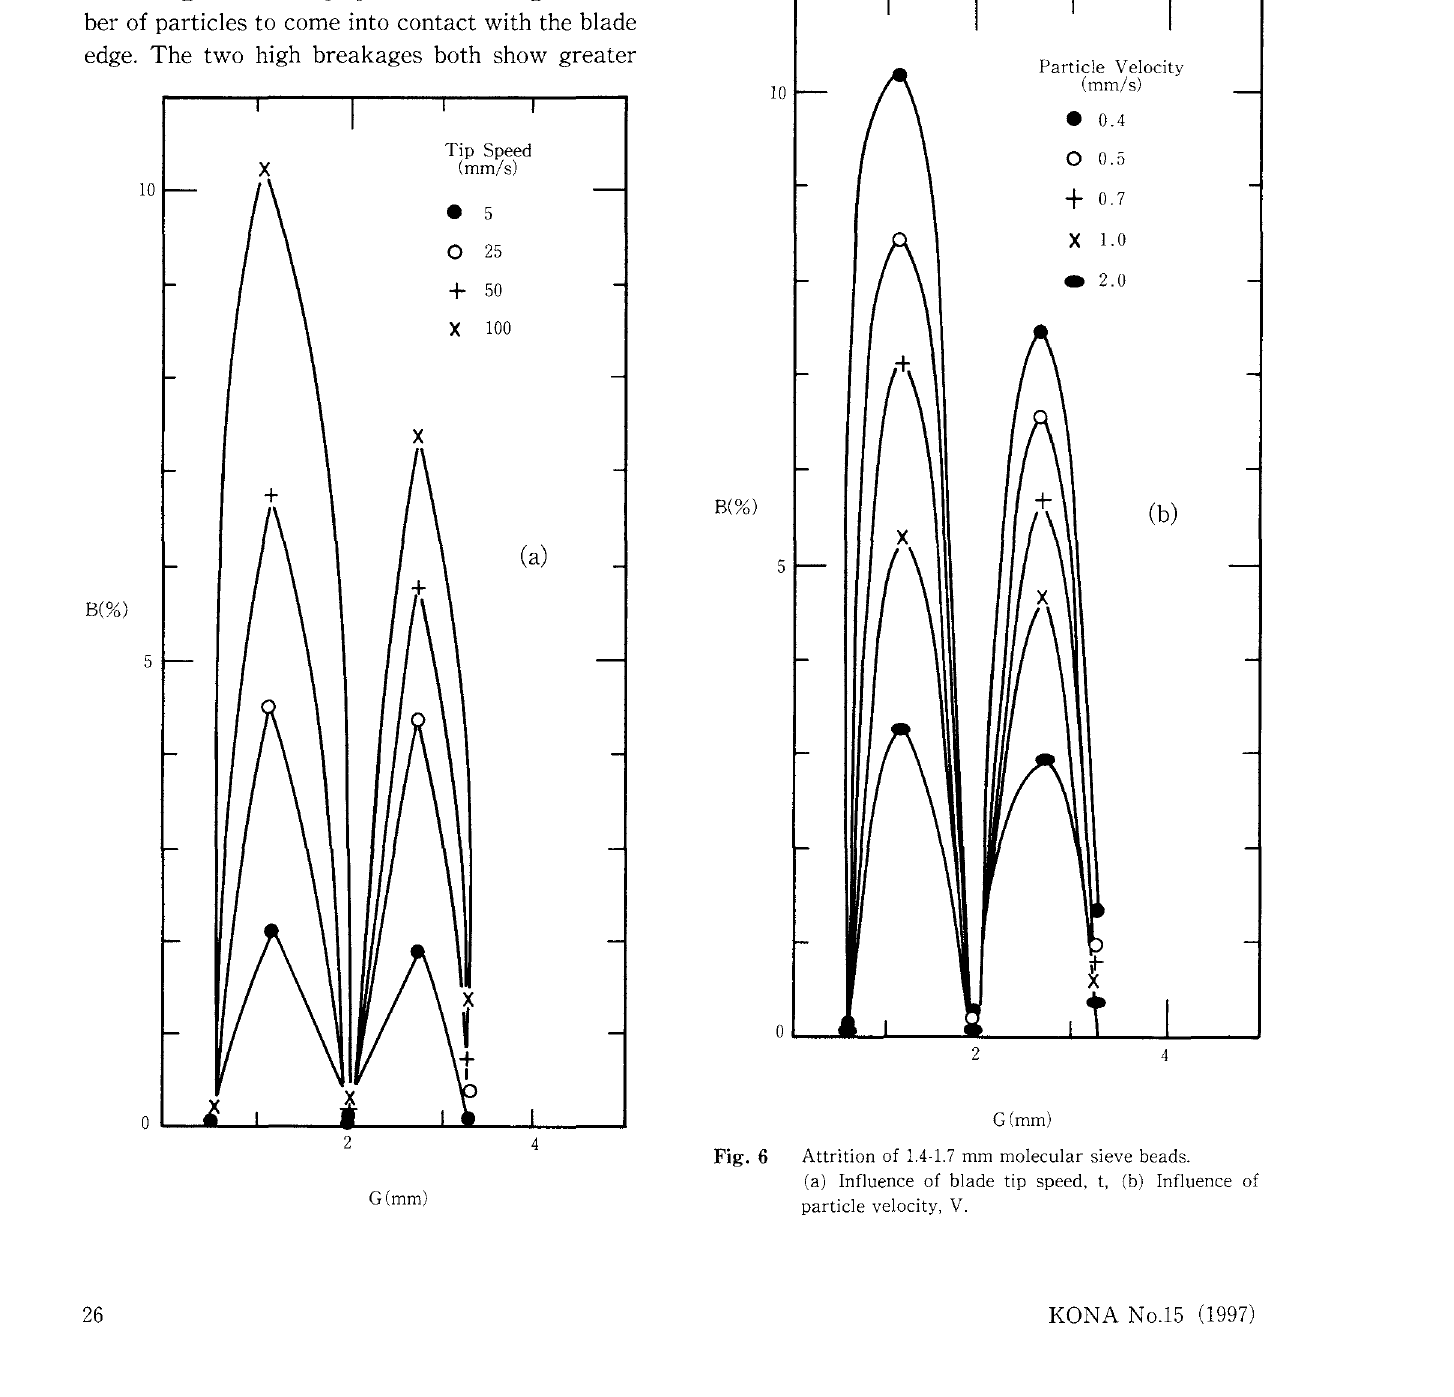
Attrition of 1.4-1.7 mm molecular sieve beads. (a) Influence of blade tip speed. t, (b) Influence of particle velocity, V.